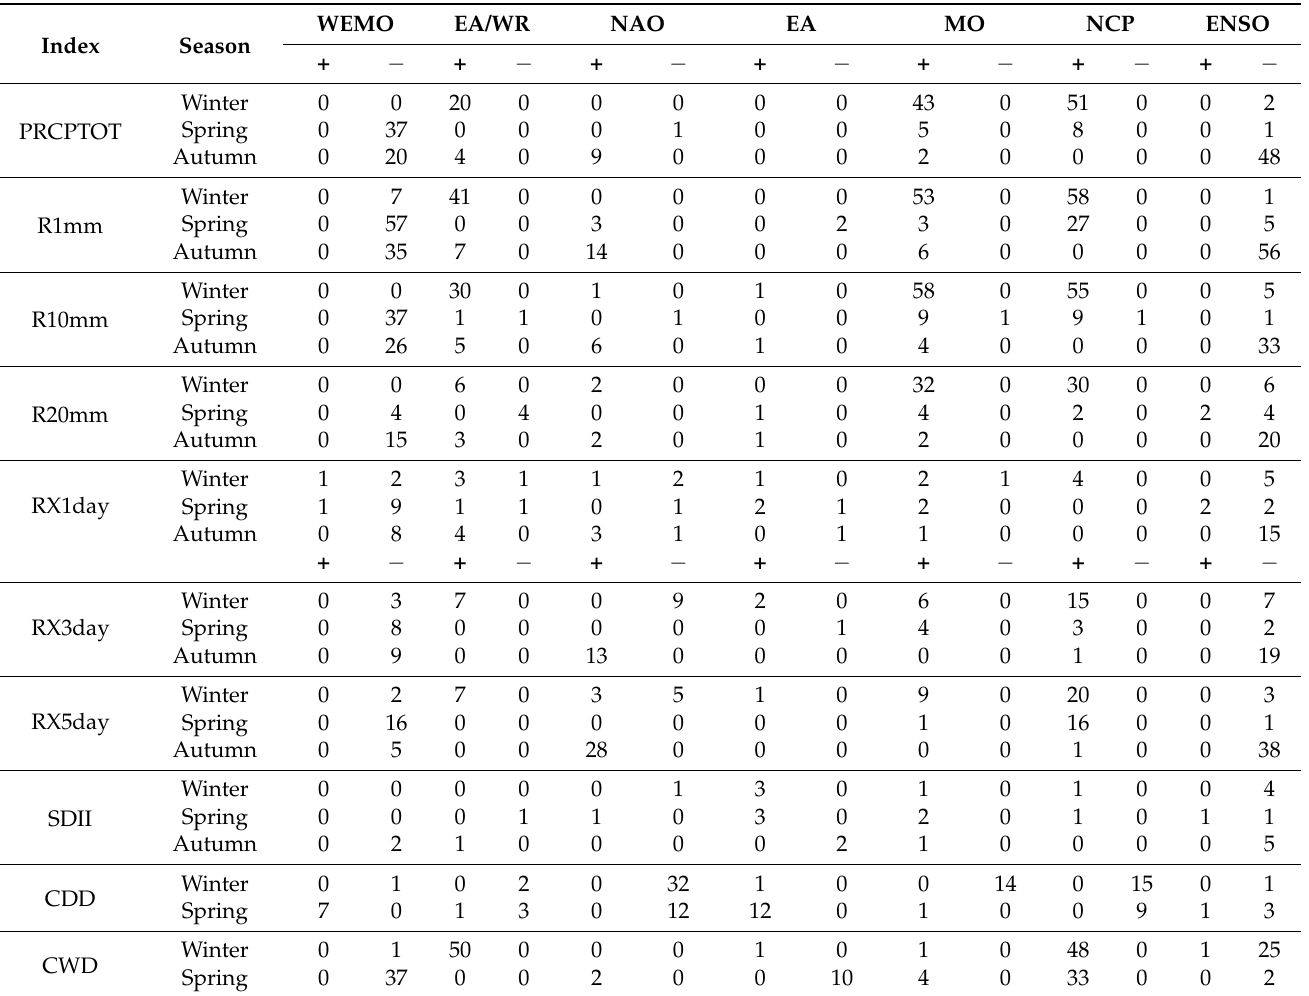
Table 5. Number of stations with significant positive or negative correlations between extreme precipitation and teleconnection indices, at a seasonal scale. Only significant results at the 95% confidence level are